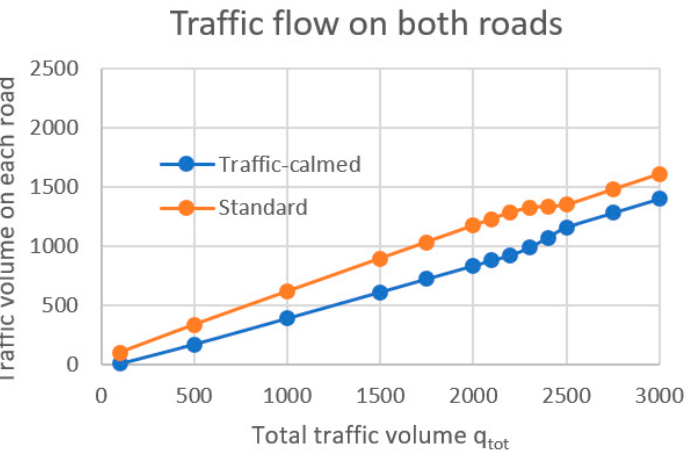
Figure 19. Traffic flow on both roads with the same volume–delay function and different v 0 velocities, source: own.